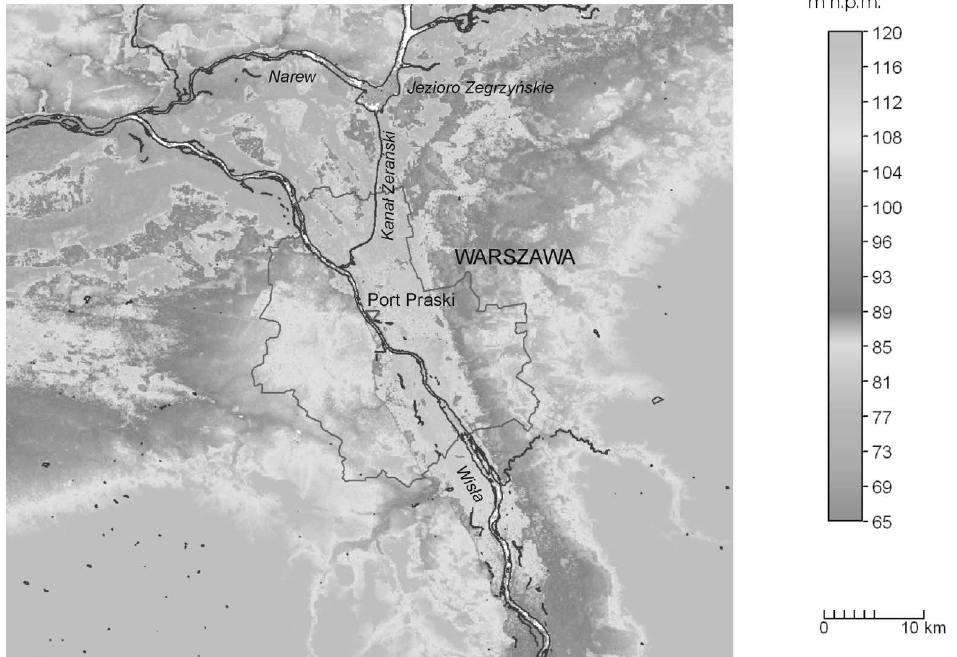
Fig. 1 Hypsometry of the Vistula River valley in Warsaw area (data of SRTM obtained from Global Land Cover Facility, University of